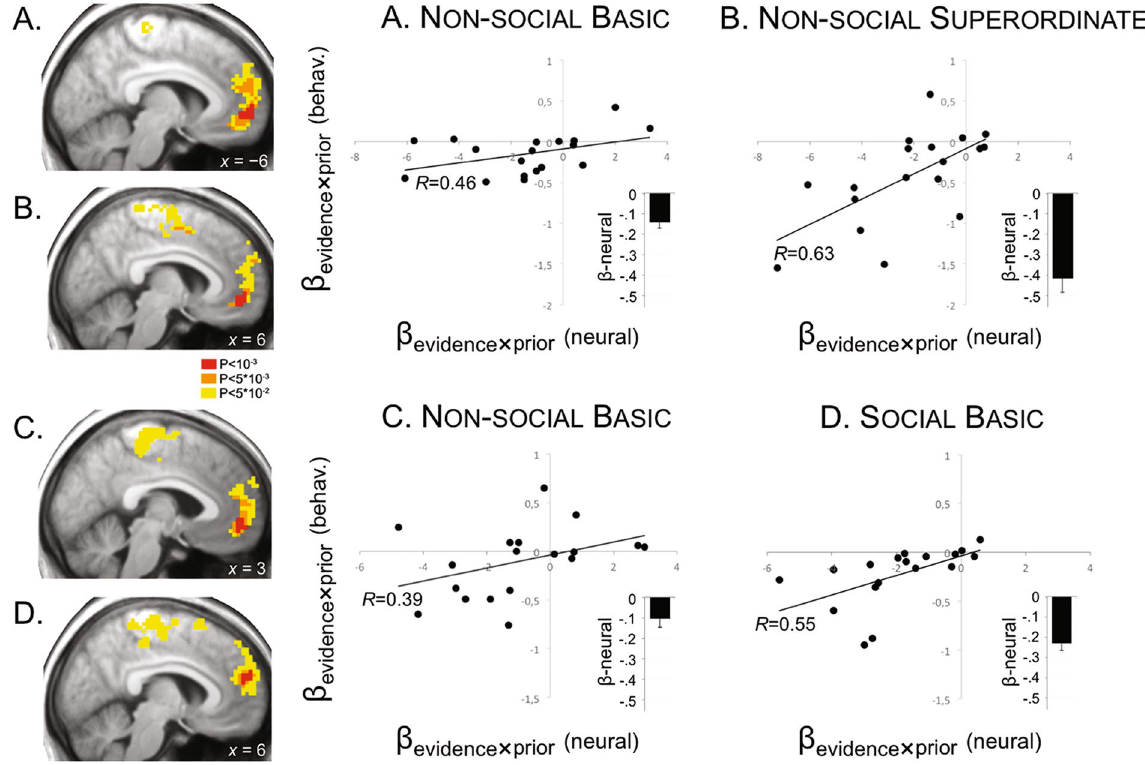
Figure 4. Event-related response in the medial prefrontal cortex (mPFC) reflects individual tendency to rely on priors as visuomotor evidence decreases. Left panel : in the mPFC, parametric response to priors as a function of visuomotor evidence for each type of intention (Non-Social Basic: x, y, z = − 6, 57, 0; Non-Social Superordinate: x, y, z = 6, 48, − 6; Non-Social Basic: x, y, z = 3, 45, − 6; Social Basic: x, y, z = 6, 54, 15). We rendered our map using an uncorrected threshold of P < 0.001 (level of significance used for inference, red voxels) and thresholds of P < 0.005 and P < 0.05 (orange and yellow voxels) to show the full extent of the activations. Right panel : scatter plots of correspondence between individual β -behaviour and β -neural estimates of the prior-by-evidence interaction. For each participant, the two estimates link modulation of choice probability by visuomotor evidence and event-related responses in mPFC (See Material and Methods). Individual differences in β -behaviour estimates of the prior-by-evidence interaction were predicted by individual differences in β -neural extracted from individual mPFC ROIs. Higher β -behaviour estimates directly reflect the strength of visuomotor evidence over choice probability, with participants showing greater reliance on their priors as the amount of evidence decreases. Inserted charts in A, B, C, and D, show value of the β -neural coefficient in each